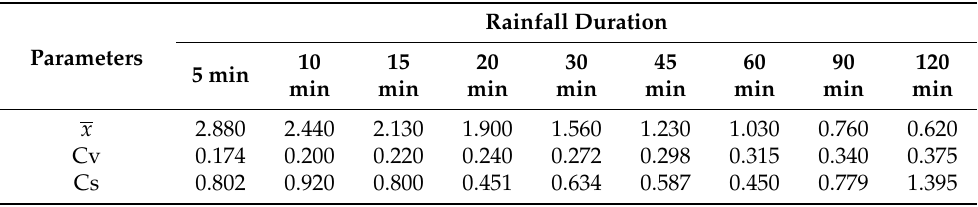
Table 2. Same as Table 1 but for representative concentration pathway (RCP) 4.5 scenario.